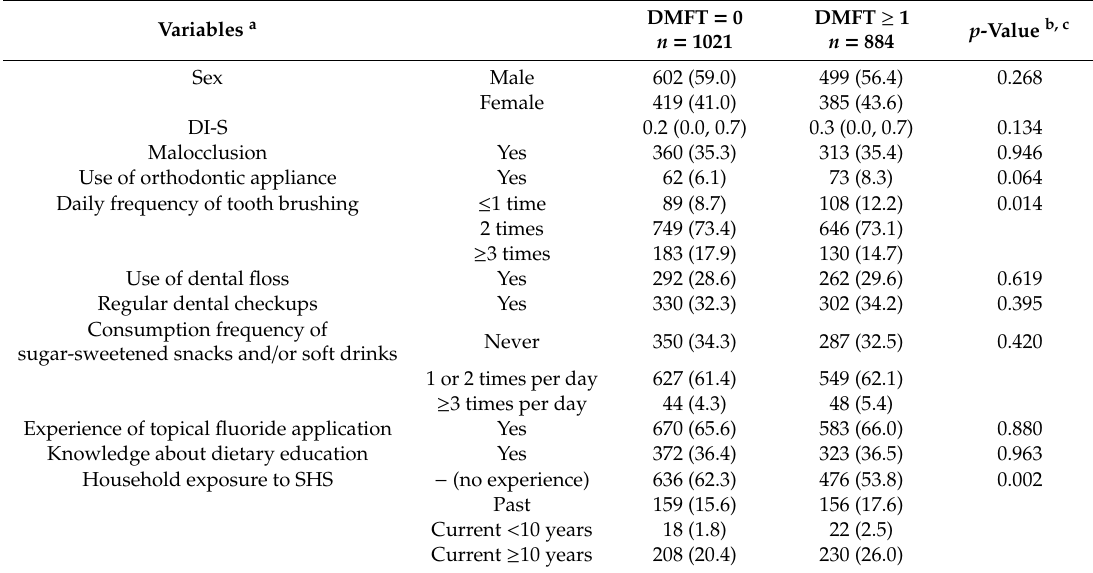
Table 2. Di ff erences in variables between DMFT = 0 and DMFT ≥ 1 groups.